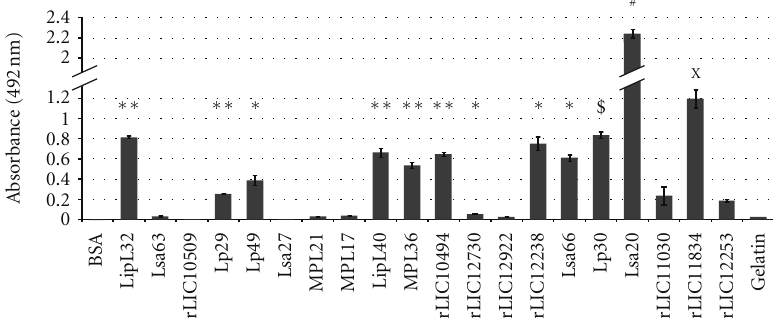
Figure 6: Binding of leptospiral recombinant proteins to human plasminogen. The recombinant proteins LipL32, Lsa63, rLIC10509, Lp29, Lp49, Lsa27, MPL21, MPL17, LipL40, MPL36, rLIC10494, rLIC12730, rLIC12922, rLIC12238, Lsa66, Lp30, Lsa20, rLIC11030, rLIC11834, and rLIC12253 were coated onto 96-well ELISA plates (10 μ g/mL) and allowed to interact with purified human PLG (10 μ g/mL). BSA and gelatin were used as a negative control for nonspecific binding. Binding was detected and quantified by specific antibodies. Bars represent the mean absorbance values at 492nm ± the standard deviation of four replicates for each protein and are representative of three independent experiments. Statistically significant binding in comparison to negative control BSA are shown by ∗ ( P < 0.001); ∗∗ ( P < 0.0001); $ ( P < 0.02); # ( P < 0.0005). The binding of rLIC11834 and rLIC12253 was compared to its binding to gelatin X ( P < 0.005).